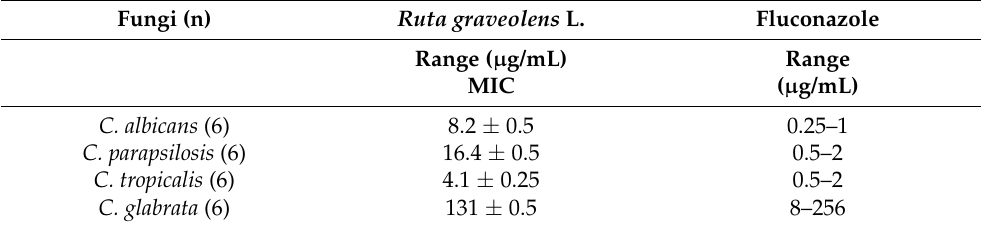
Table 1. Inhibition effect of Ruta graveolens L. against different Candida species.